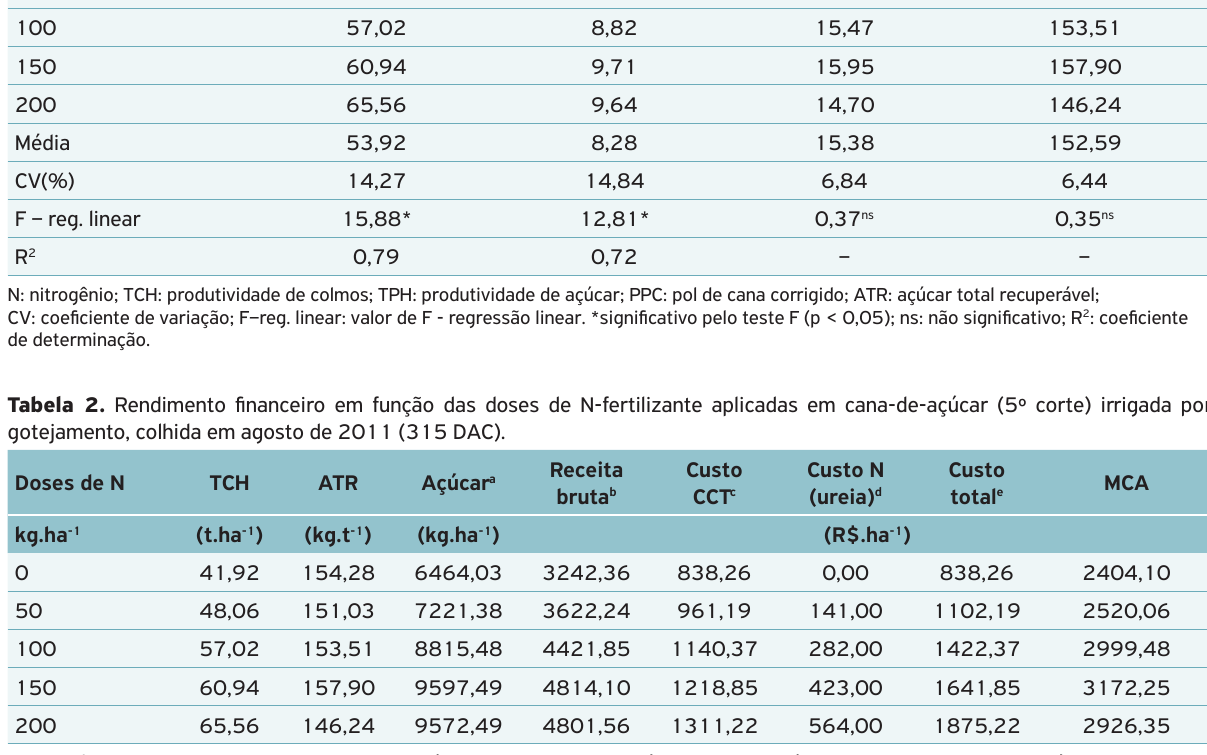
Tabela 1. Produtividade de colmos, produtividade de açúcar, pol de cana corrigido e açúcar total recuperável em razão de diferentes doses de N-fertilizante, em cana-de-açúcar irrigada por gotejamento, no mês de agosto, safra de 2011.